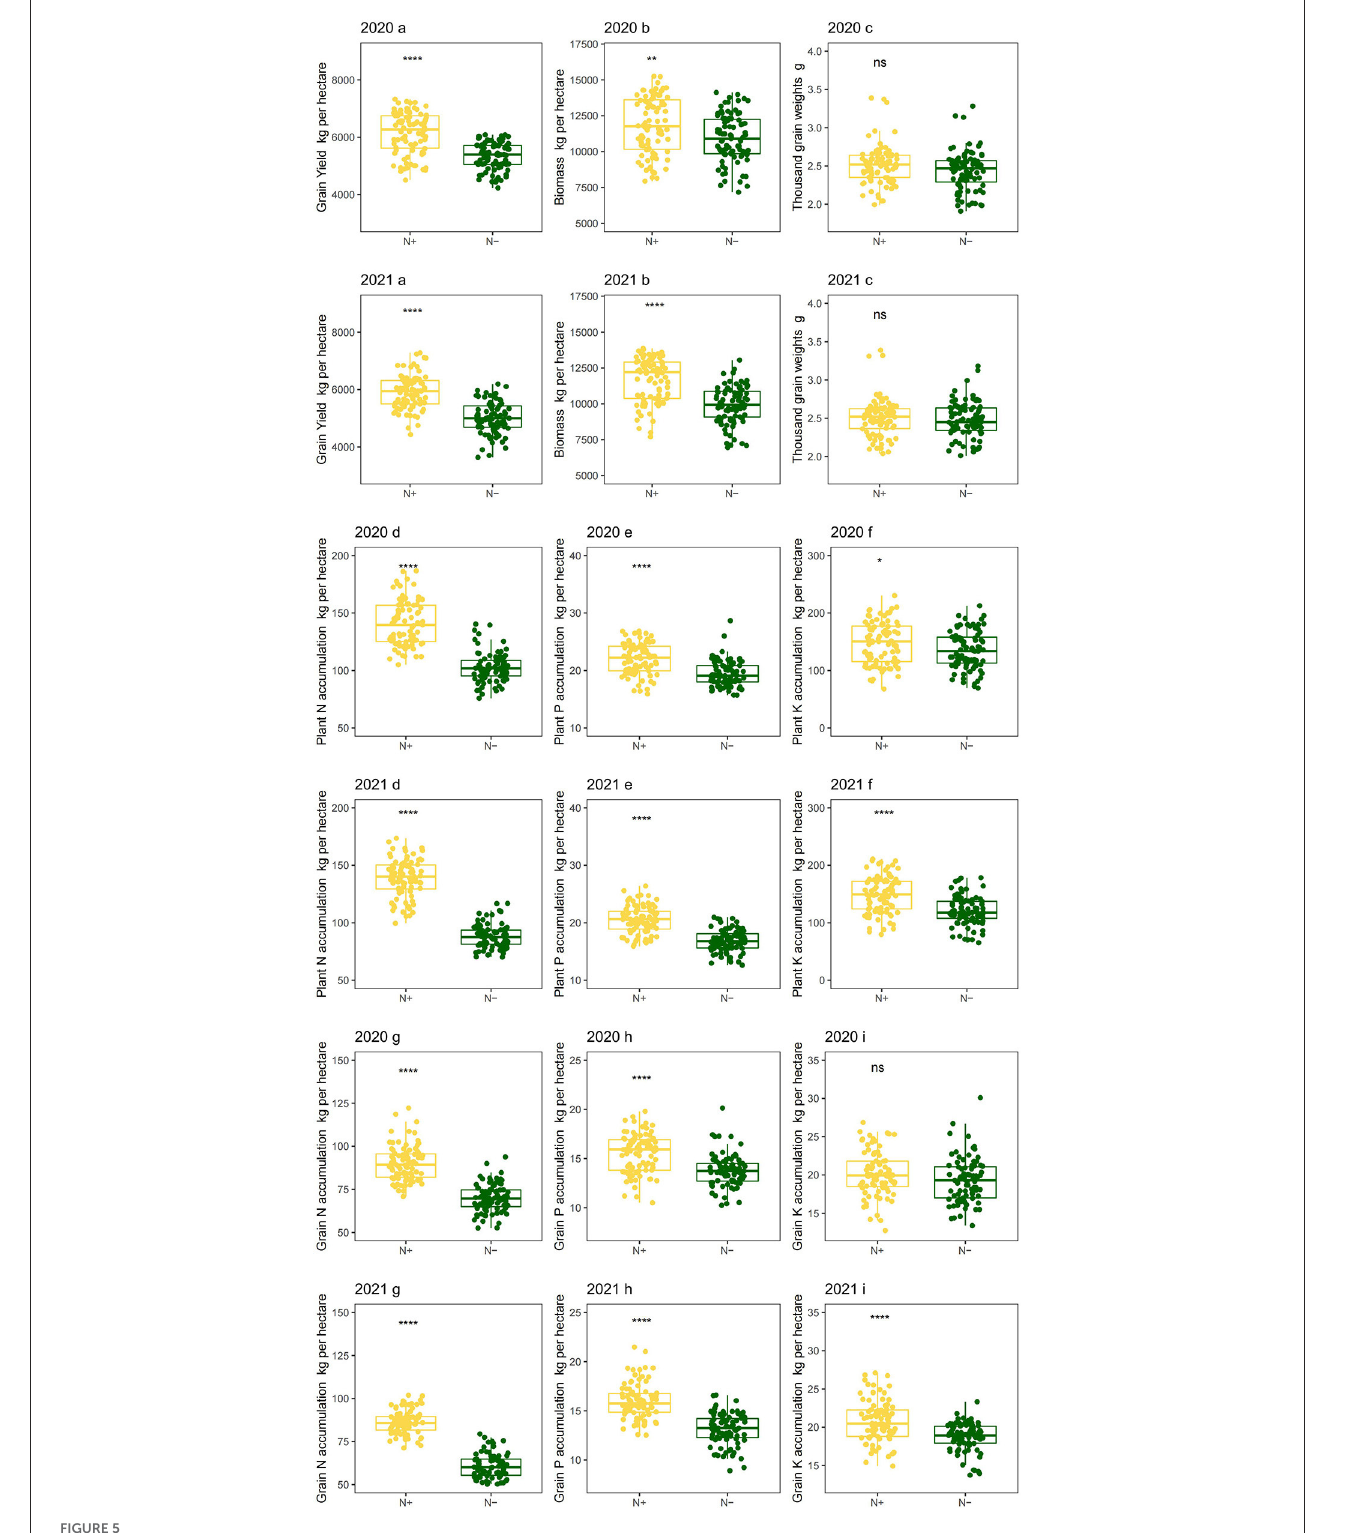
FIGURE5 Crop production and nutrient accumulation of foxtail millet under low-N stress in 2 years. Grain yield per hectare (2020a in 2020; 2021a in 2021), aboveground biomass per hectare (2020b in 2020; 2021b in 2021), thousand grain weights (2020c in 2020; 2021c in 2021), plant N accumulation per hectare (2020d in 2020; 2021d in 2021), plant P accumulation per hectare (2020e in 2020; 2021e in 2021), plant K accumulation per hectare (2020f in 2020; 2021f in 2021), grain N accumulation per hectare (2020g in 2020; 2021g in 2021), grain P accumulation per hectare (2020h in 2020; 2021h in 2021) and grain K accumulation per hectare (2020i in 2020; 2021i in 2021). N–, N deficiency; N + , N applied treatment. *, **, **** and ns indicate significant differences at 0.05, 0.01, 0.0001 and no significant difference, respectively. Error bars represent the standard error of folate